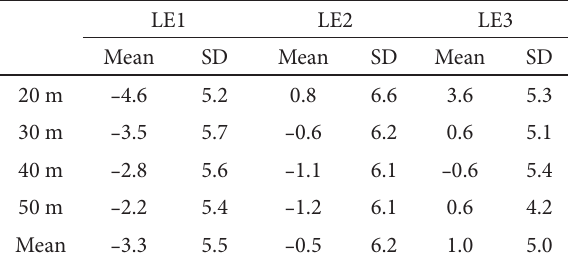
Table 3. Errors for all load effects examined in 25 Scenario Modelling runs (LE1 = mid-span bending, LE2 = shear, LE3 = hogging moment over central support)